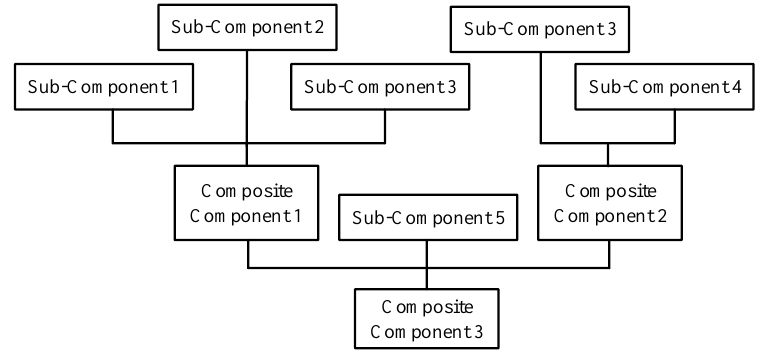
Figure 8. Multilevel composite component.